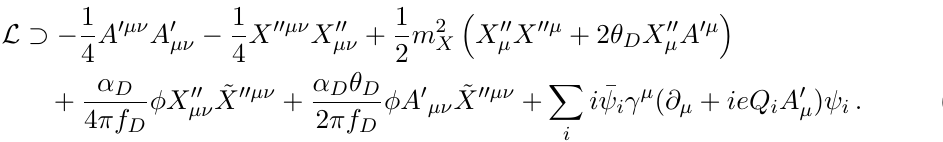
Figure 4 . Feynman diagram of the process relevant for stellar cooling constraints on the dark relaxion, where a plasmon γ decays to the dark relaxion φ and a dark photon X